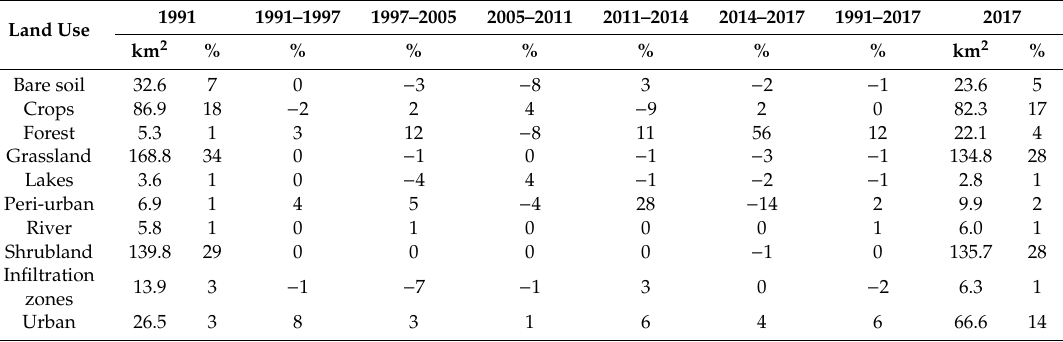
Table 5. Area (km 2 ) and percentage of di ff erent land use classes in the Rocha River catchment in